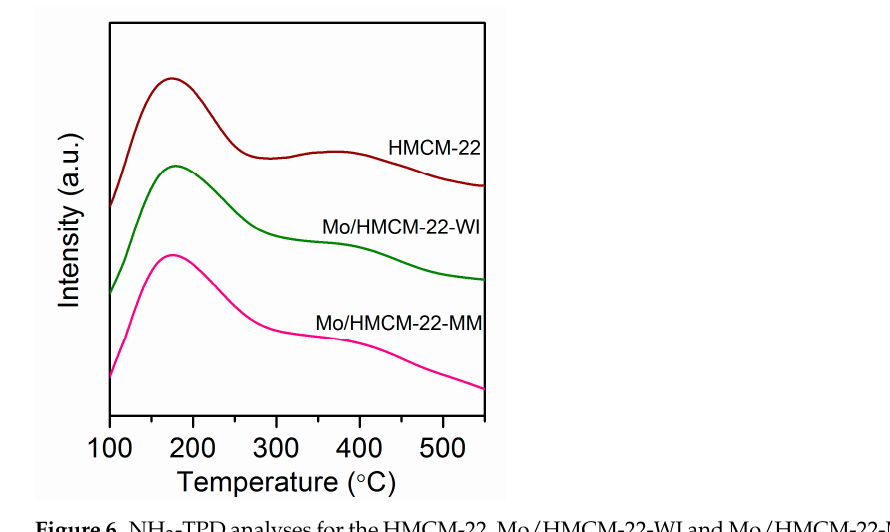
Figure 6. NH 3 -TPD analyses for the HMCM-22, Mo/HMCM-22-WI and Mo/HMCM-22-MM sam- ples.